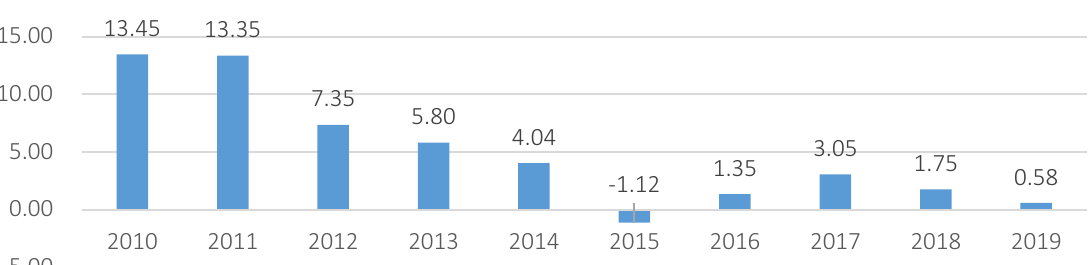
Figure 5. China-Thailand trade deficit from 2010 to